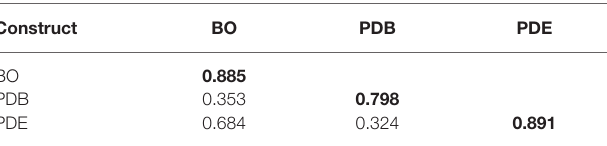
TABLE 3 | Fornell and Larcker.